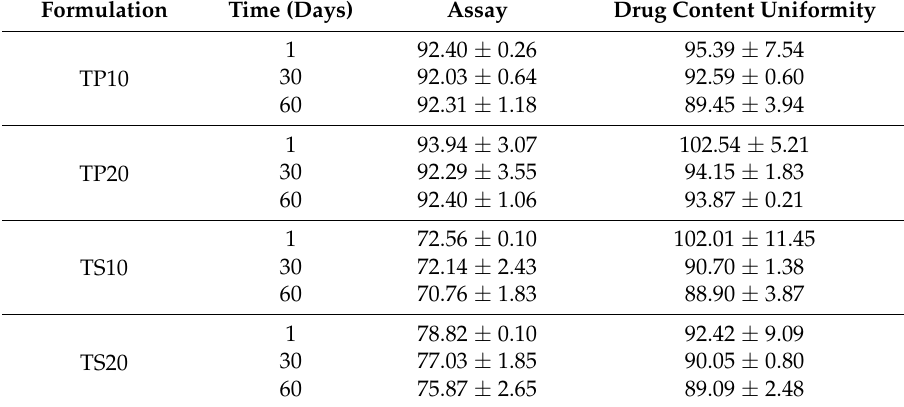
Table 1. Assay and drug uniformity content of triamcinolone acetonide 10% and 20% w / w polyethylene oxide (PEO) and Soluplus ® melt-cast film formulations (mean ± SD, n = 3).